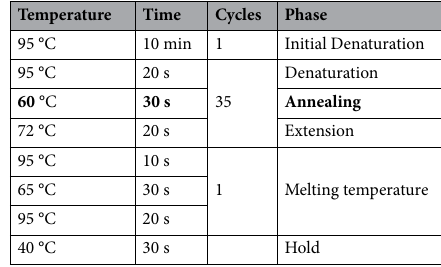
Table 5. Thermal profile of Metalloprotease 3 and 4 (MEP3 and 4); Metallocarboxypeptidase A and B (MCP A and B); Dipeptidyl-Peptidase V (DPP V); Isocitrate lyase; Citrate synthase; Malate synthase and GAPDH. Bold indicates that at this temperature the PCR is